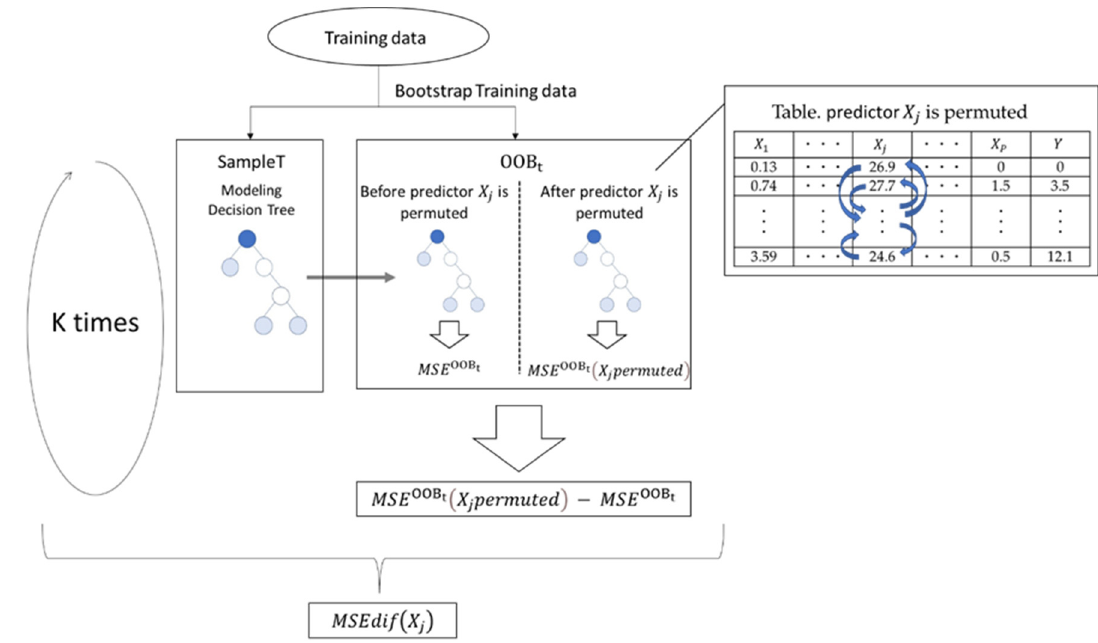
Figure 1. Feature selection by RF.